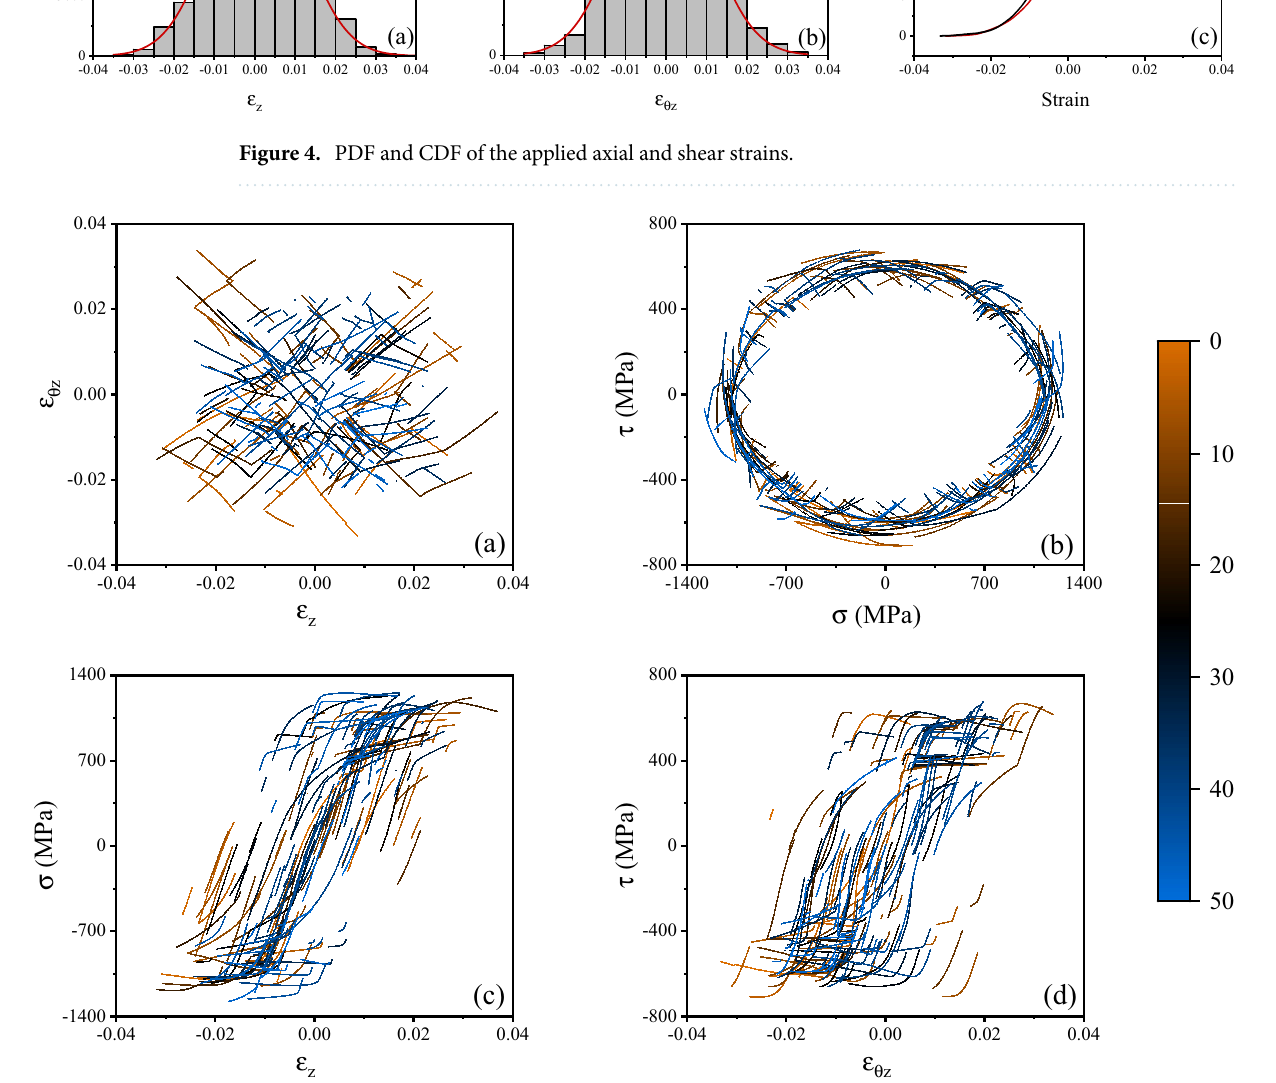
Figure 5. Visualisation of the plastic increments in the training dataset ( a ) in strain space; ( b ) in stress space; ( c ) in axial stress versus strain space; ( d ) in shear stress versus strain space. Each of the fifty different loading paths is associated to a different colour according to the colour code displayed on the